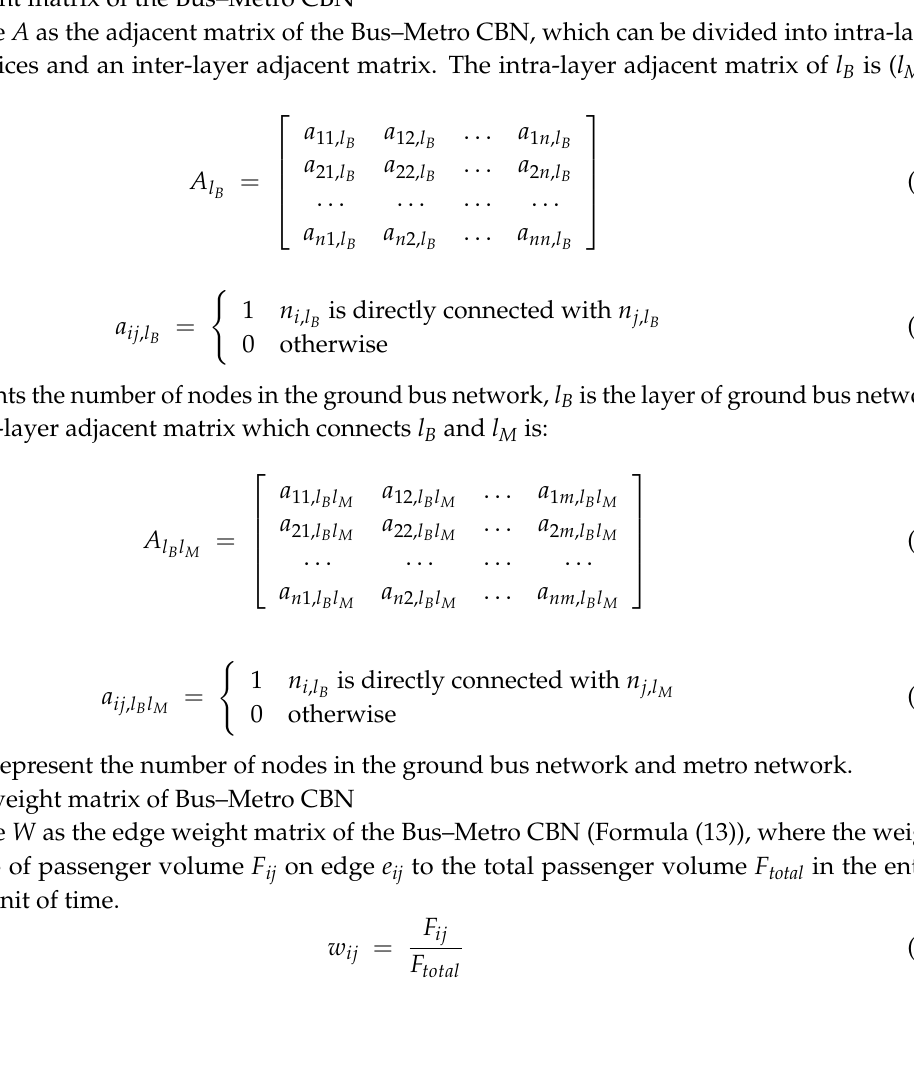
Figure 3. Schematic Bus–Metro CBN model.